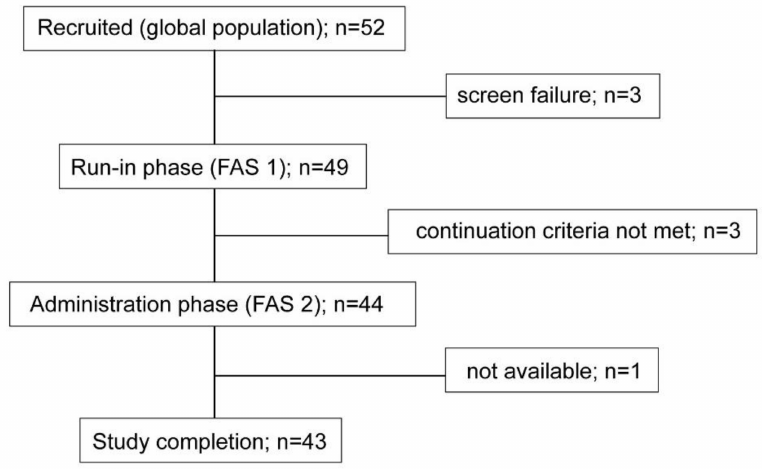
Figure 2. Flow-chart. FAS 1: full analysis set 1; FAS 2: full analysis set